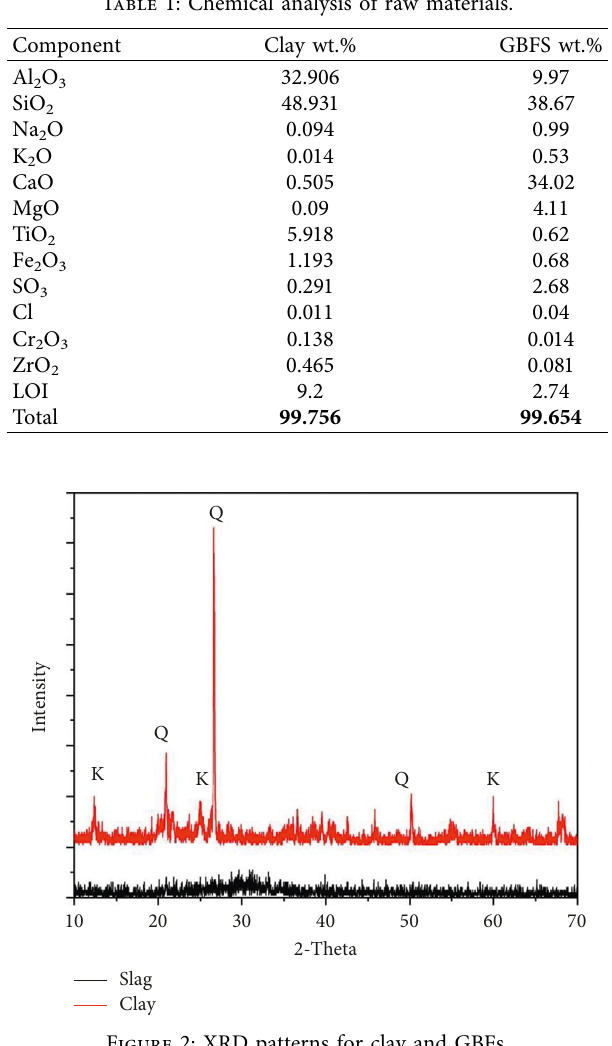
Figure 2: XRD patterns for clay and